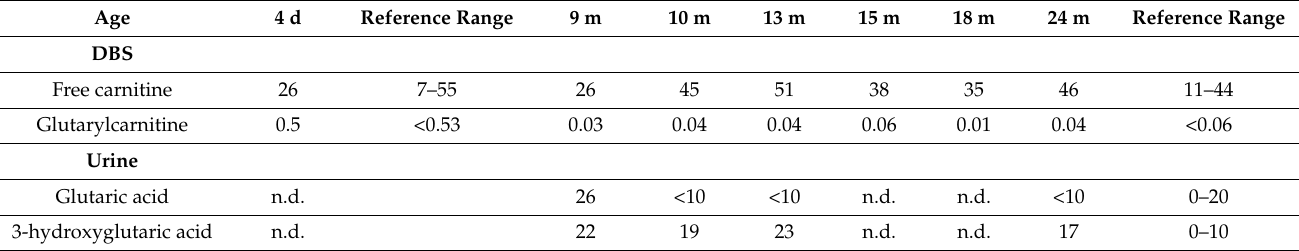
Table 1. Laboratory results of patient 1. Free carnitine and glutaryl-carnitine are in µ mol/L. DBS result from day 4 was from the NBS laboratory; all other DBS results were from the clinical chemistry laboratory. The cut-offs in both laboratories are different; organic acids are in mmol/mol creatinine; n.d. = not done. Age 4 d